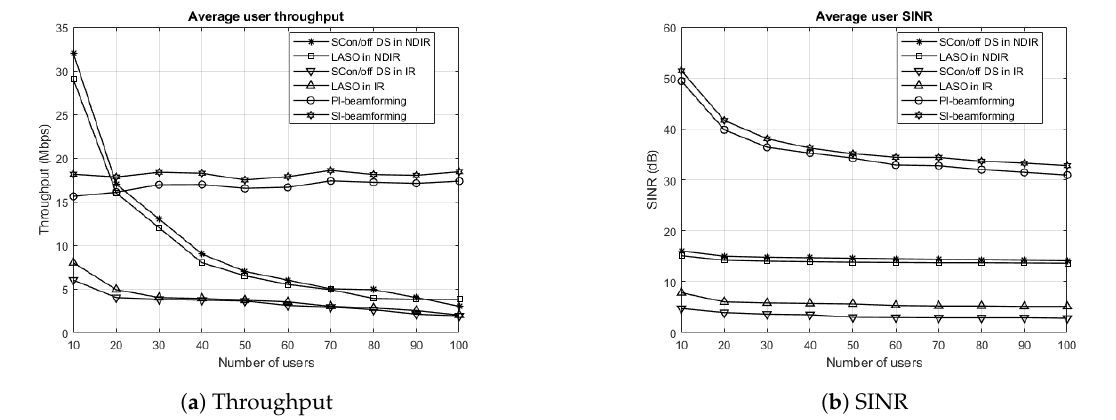
Figure 2. Throughput and SINR comparison when increasing the number of users in the service area for all